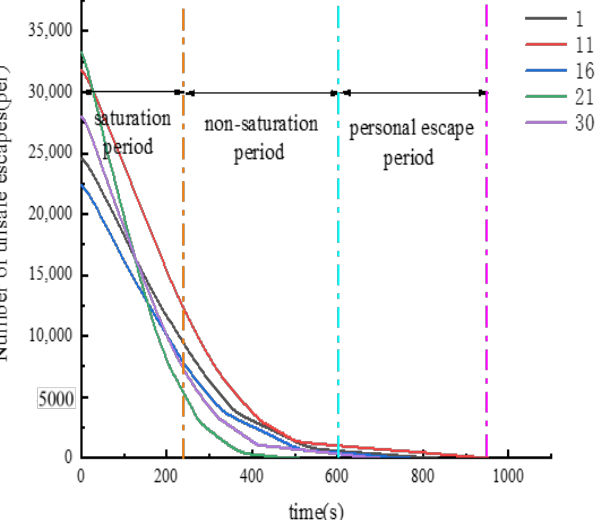
Figure 12. The curve of the number of pedestrians who failed to escape in group C with time.